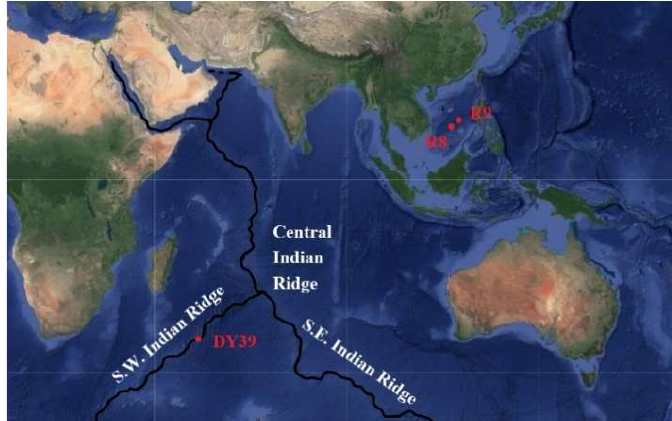
Figure 1. The geographic map of sediment sample collection